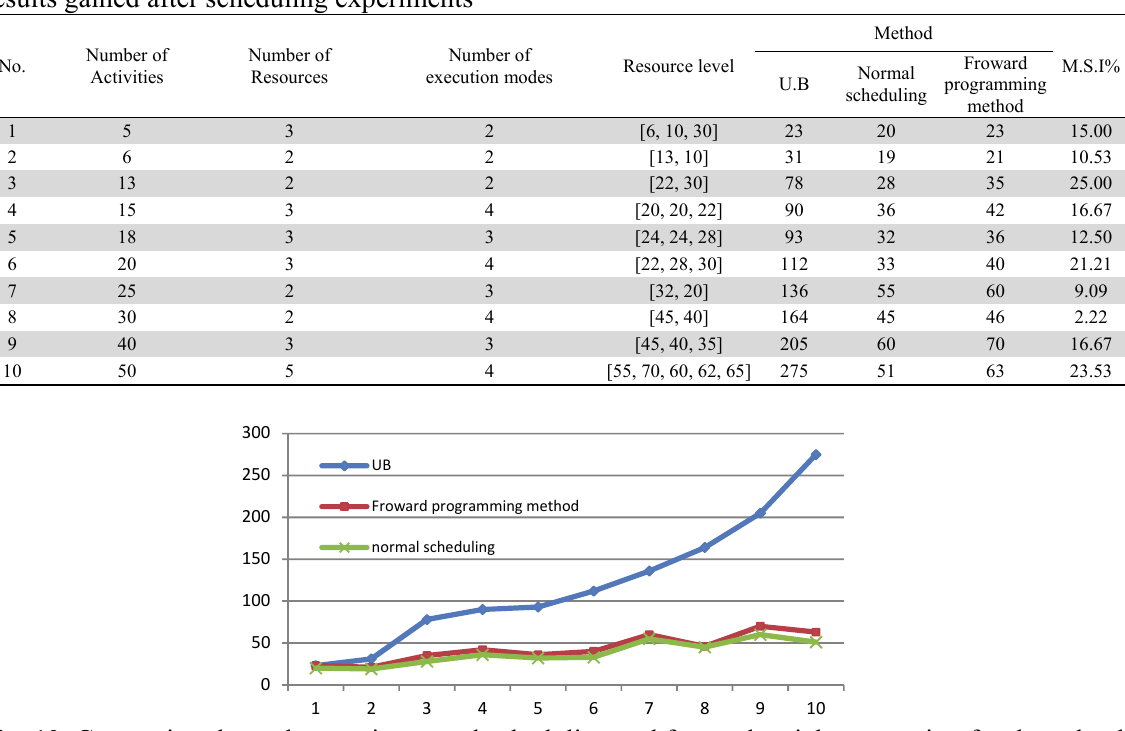
Fig. 10. Comparing the makespan in normal scheduling and forward serial programing for the solved experiments